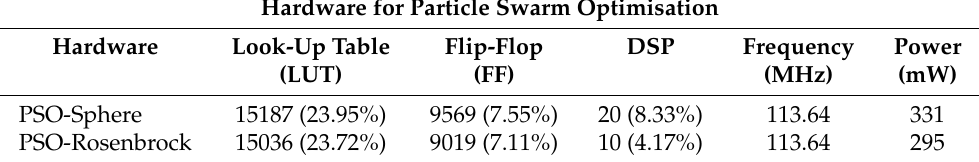
Table 6. Implementation results in the PSO design.